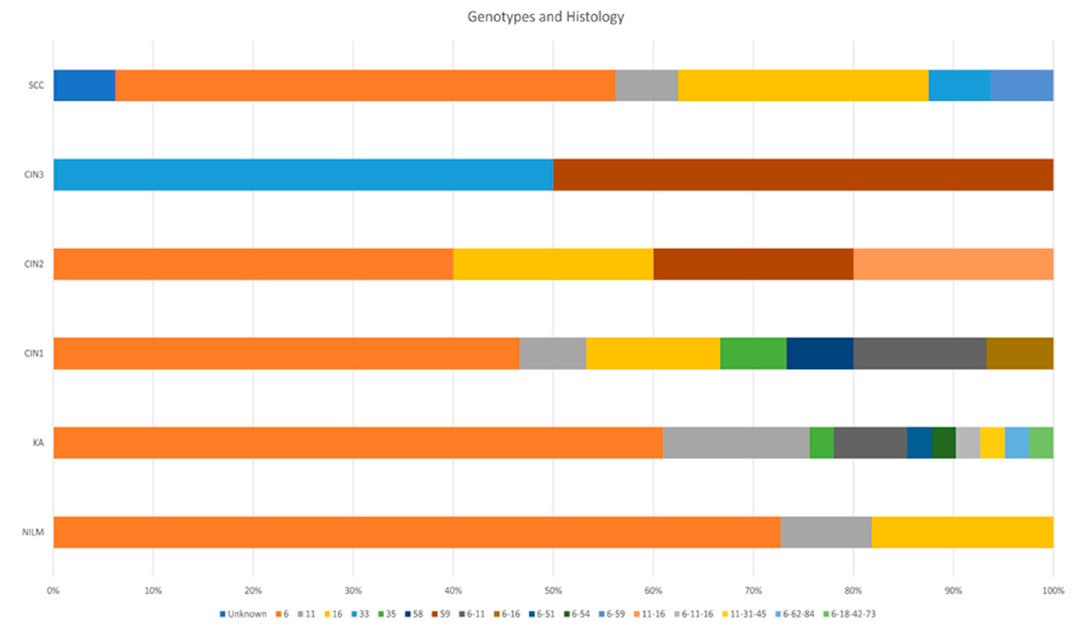
Figure 3. HPV genotypes in relation to histopathological diagnosis.